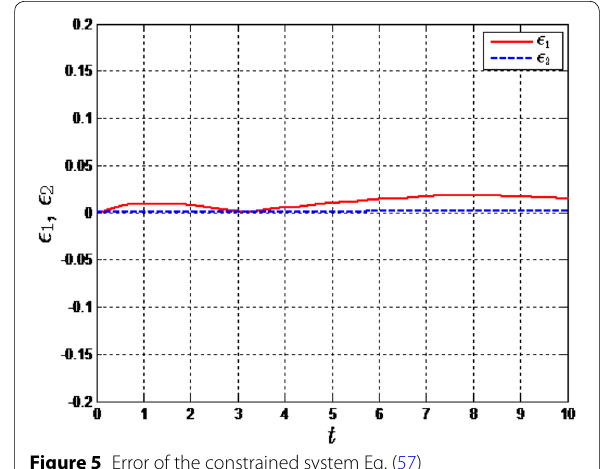
Figure 2 Relation between r and θ in constrained system Eq. (57)